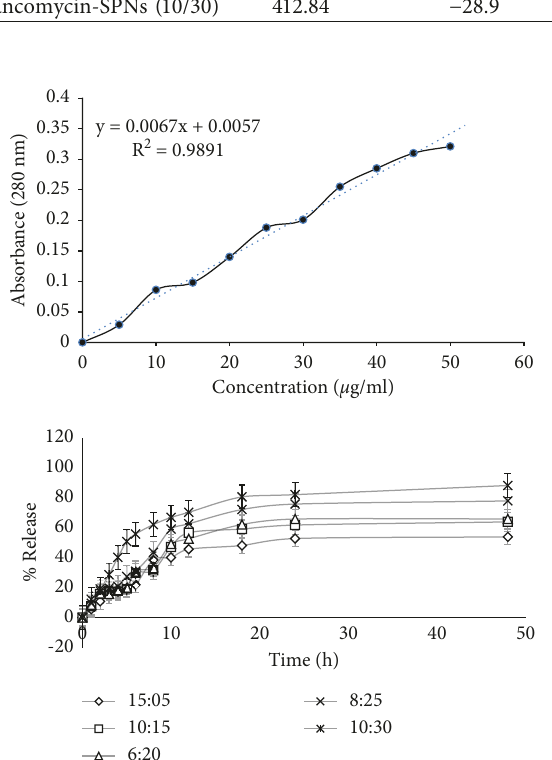
Figure 4: Standard curve of vancomycin based on absorbance at 280nm and drug release in different concentrations (mg/ml) of vancomycin:soy protein nanoparticles (vancomycin:SPNs). 15:5, 10:15, 6:20, 8:25, and 10:30 of